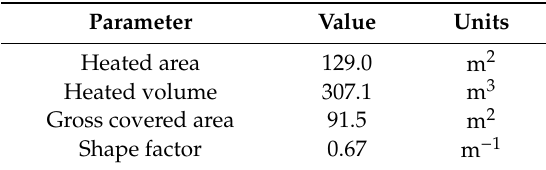
Figure 1. An axonometric projection of the building from the south-western side in the Audytor OZC software [25]. Table 2. Basic geometric